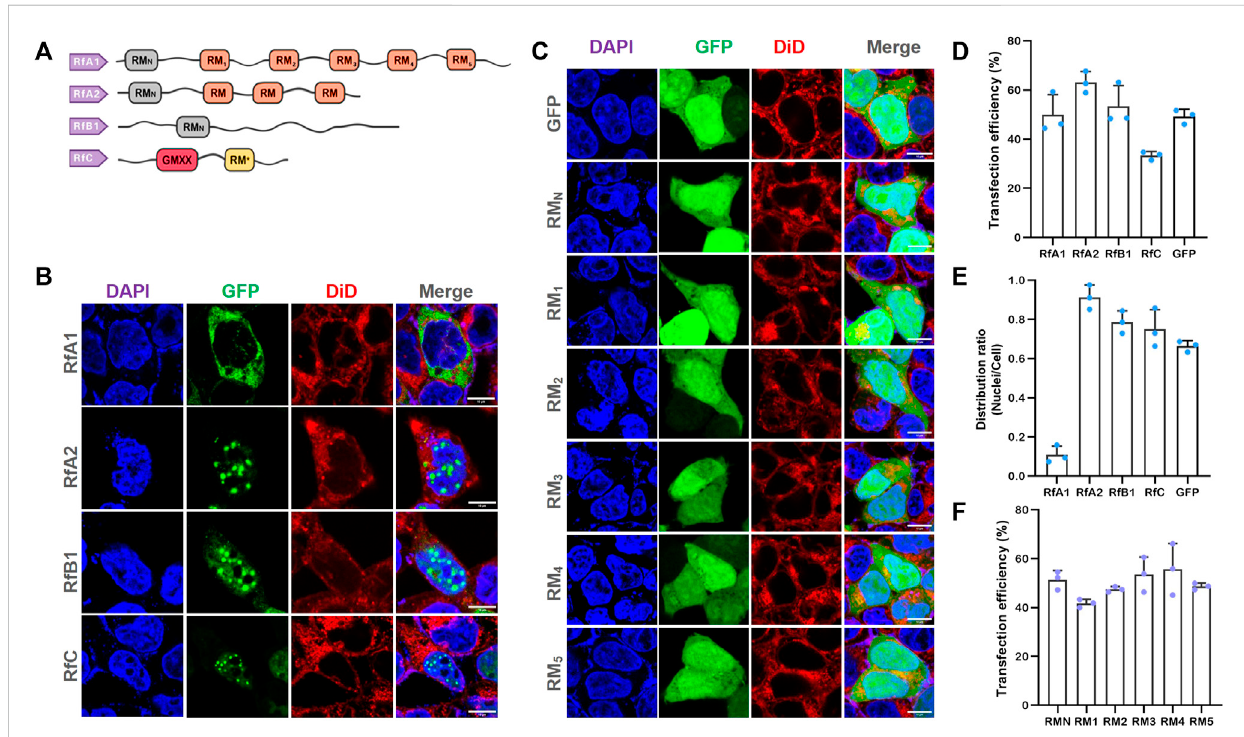
FIGURE 1 Selective Intracellular Localization of Re fl ectins and Free-Distribution of Single Motifs. (A) Schematics of re fl ectin proteins sequences. Conserved Re fl ectin Motifs (RM N and repeated RM 1-5 ) are designated by boxes, while re fl ectin linkers (RLs) are lines. (B,C) Fluorescence microscopy images of transfected HEK-293T cells stained with DAPI and DiD. While re fl ectins and variants are visualized by tandem EGFP, Scalebar = 10 μ m. (D) Cell number statisticsandquanti fi cationoftransfectionef fi cienciesoffourre fl ectinsandGFP. (E) Distributionratiostatisticsof fl uorescentintensityintransfected cellsandtheirnuclei. (F) Cellnumberstatisticsandquanti fi cationoftransfectionef fi cienciesof fi vesingleRMs.Dataarepresentedasmeanvalues±SDfor n = 3 independent